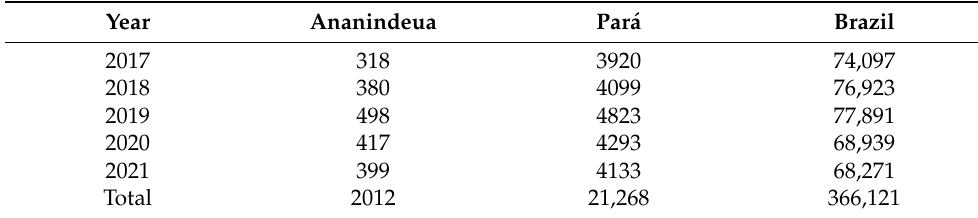
Table 1. Number of new TB cases notified in the municipality of Ananindeua, state of Par á and Brazil from 2017 to 2021.